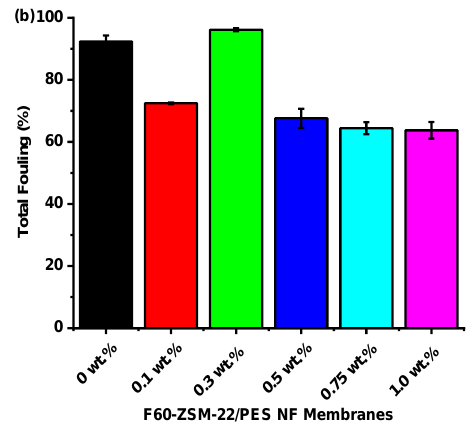
pared with the pure PES membrane, the resulting NF membranes exhibit smaller fouling values. This can be expressed by the total fouling analysis shown in Figure 12.